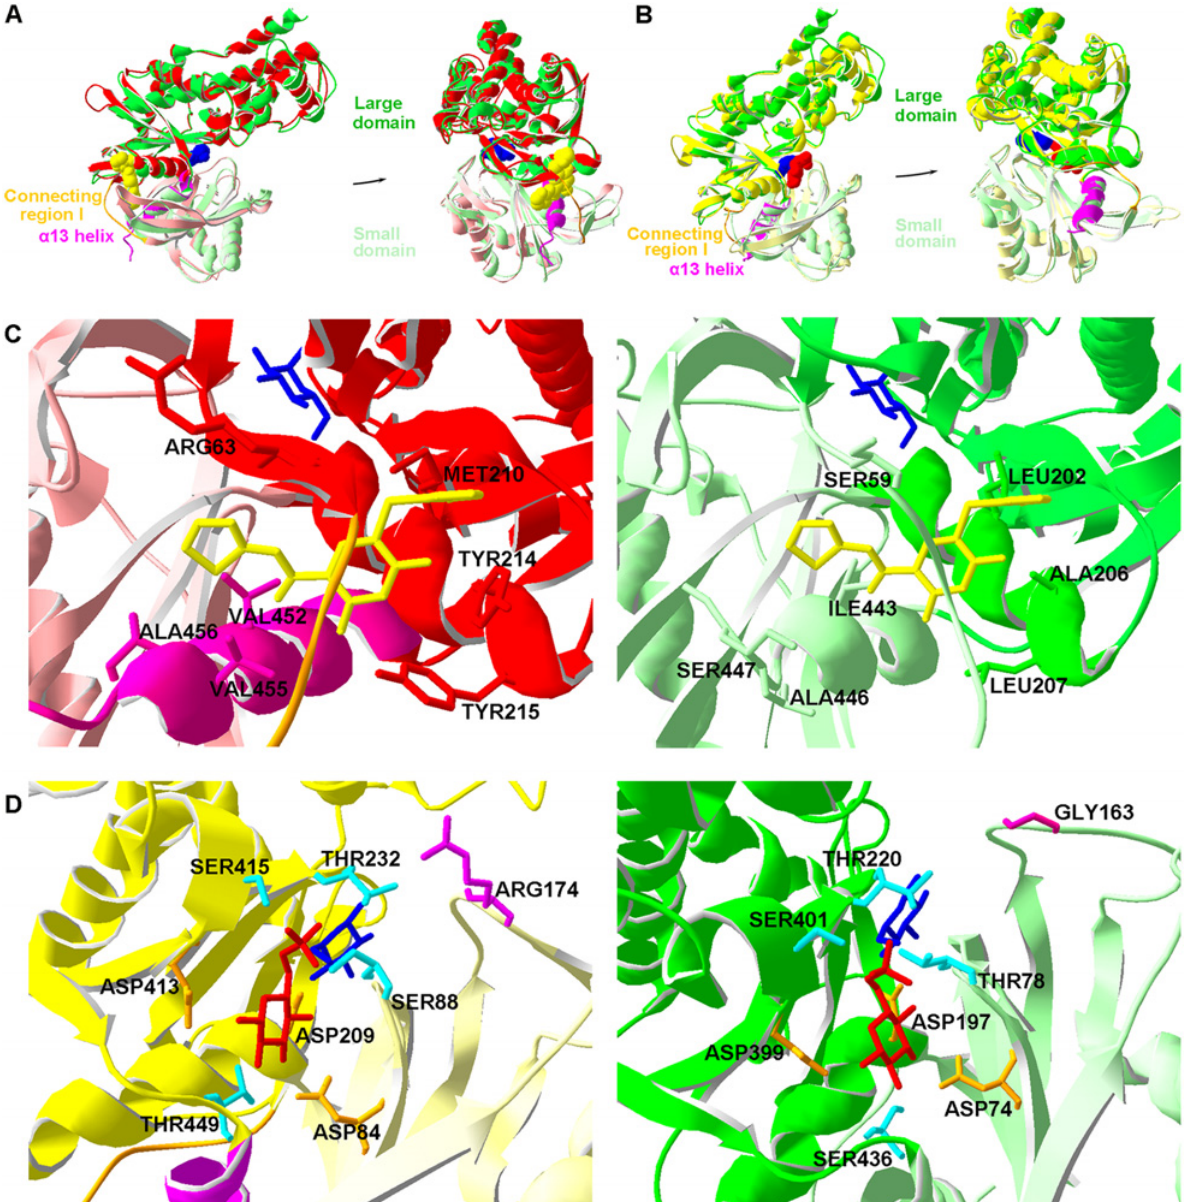
Fig 1. Comparison of putative spatial structure of Cs HK with hHK-IV or rHK-In. (A) Ribbon drawing of superposed structure models of Cs HK (green and light green) and closed-form hHK-IV (red and light red, PDB: 1V4S_A), which structures are complexed with glucose (blue ball) and MRK (N-thiazol-2-yl-2- amino-4-fluoro-5-(1-methylimidazol-2-yl) thiobenzamide, an allosteric activator, yellow ball). The α 13 helix (magenta and light green) is included in the small domain of the closed-form. (B) Ribbon drawing of superposed structure models of Cs HK (green and light green) and rHK-In (yellow and light yellow, PDB: 1BG3_B), which structures are complexed with glucose (blue ball) and G6P (red ball). The α 13 helix (magenta and light green) is included in the small domain of the closed form. The structures of the α 13 helix and connecting region I (brown and light green) are different. (C) Stereo view of the allosteric sites in closed-form hHK-IV (left) and Cs HK (right). In the left panel, the allosteric sites are located below connecting region I (brown, ribbon model). MRK (yellow stick) forms hydrogen bonds with ARG63 and TYR215 (red stick) and hydrophobically interacts with MET210, TYR214 (red stick) of α 5 helix (red ribbon) and V452, V455 (magenta stick) of α 13 helix (magenta ribbon). The supposed corresponding structure of Cs HK is shown in the right panel. (D) Stereo view of G6P binding sites in rHK-In (left) and Cs HK (right). Interactions of G6P (red stick) with the large (yellow) and small (light yellow) domain of the rHK-In binding cleft are shown in the left panel. SER/THR residues are colored light blue (stick), and ASP residues are orange (stick). Glucose (blue stick) is bound at an adjacent position in the cleft. The ARG174 side chain unique to rHK-In is shown in magenta (stick). The supposed corresponding structure of Cs HK is shown in the right